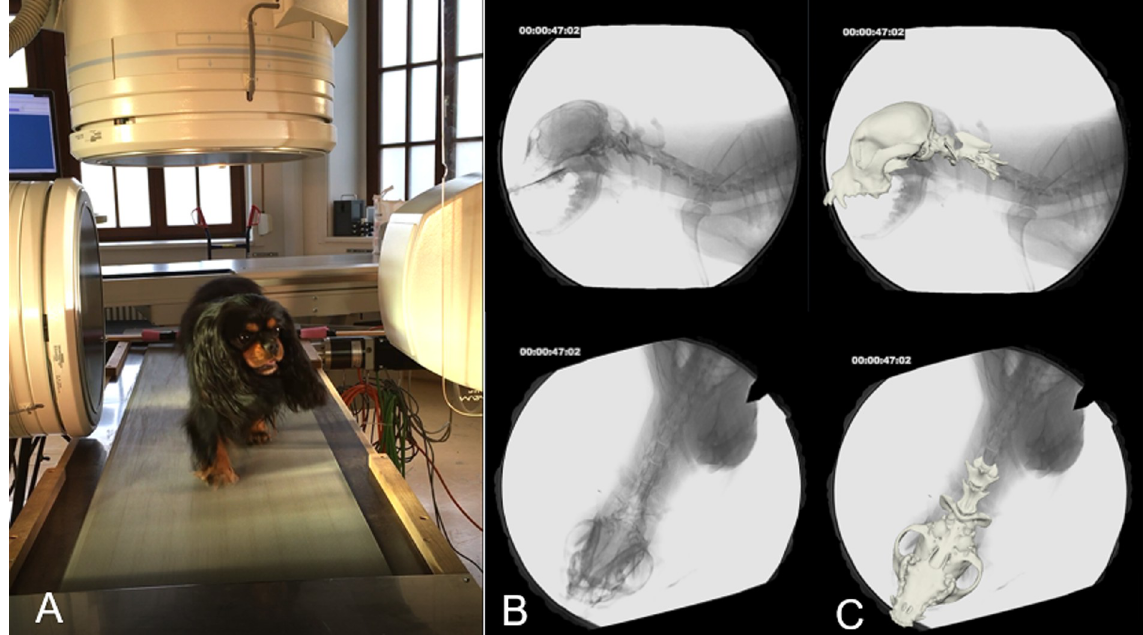
Fig 1. Biplanar fluoroscopy–setting and example. A: Biplanar fluoroscopy examination with a CKCS on the treadmill, 90˚ camera settings. B. Fluoroscopy images of the same CKCS in laterolateral and dorsoventral views. C. Fluoroscopy images and superimposed 3D bone model.